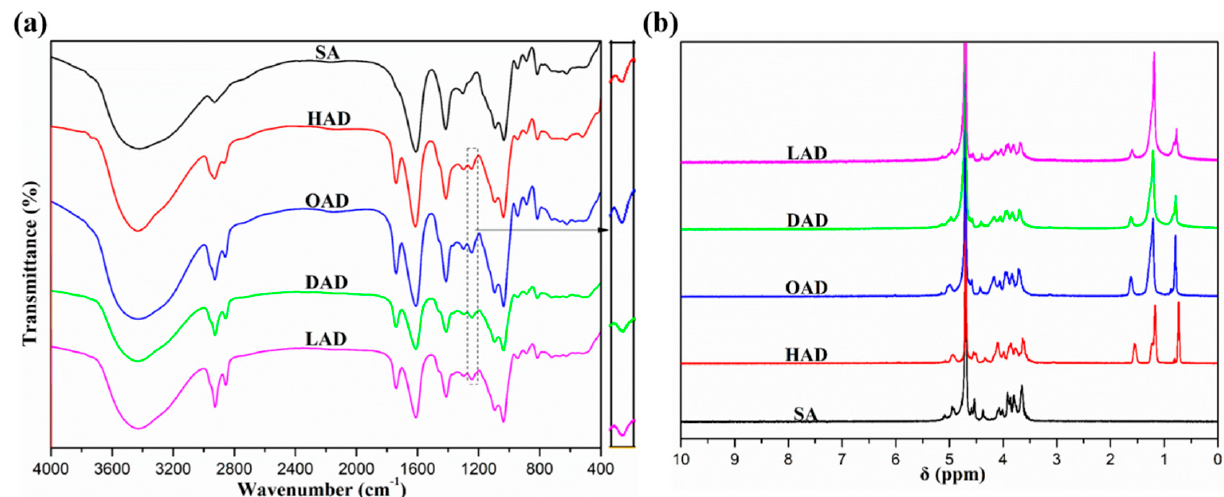
Figure 2. ( a ) FT-IR and ( b ) 1 H NMR spectra of SA, HAD, OAD, DAD and LAD.